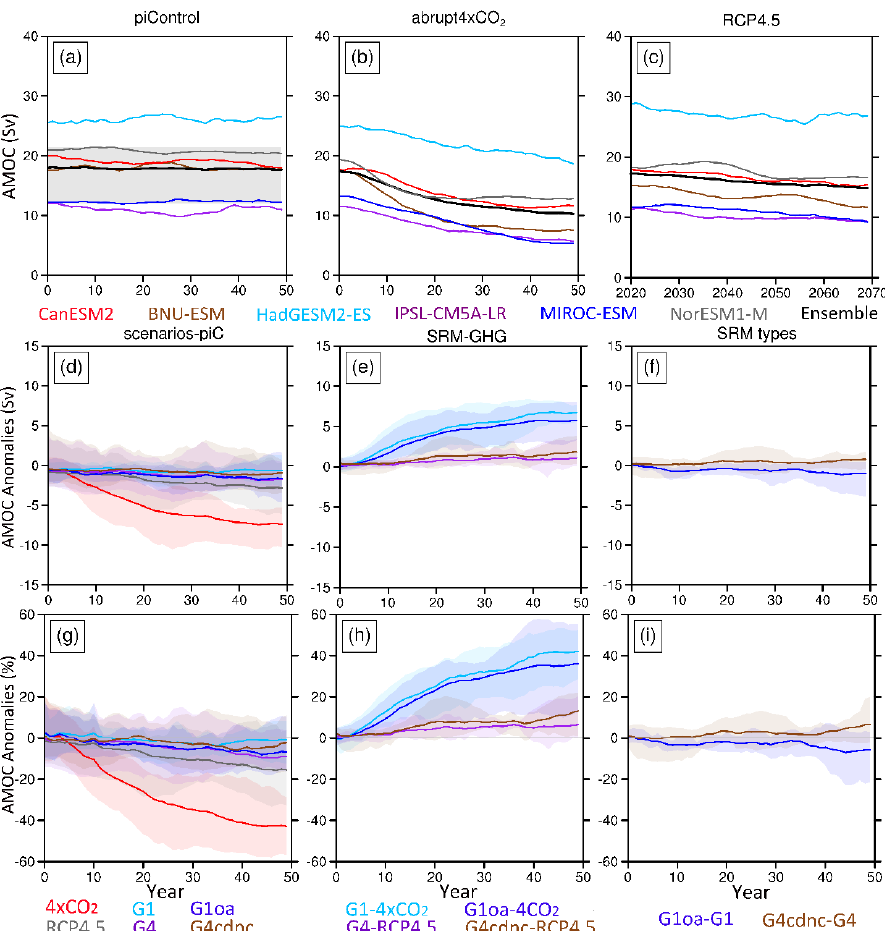
Figure 2. The 11-year running annual means simulated by the six ESMs and the multimodel ensemble mean (black curve) of the AMOC strength (Sv) over the 40-year analysis period under (a) piControl, (b) abrupt4 × CO 2 and (c) RCP4.5. The gray band in (a) is the range of AMOC intensity (17.0 ± 4.4Sv) measured by the RAPID- MOCHA (Frajka-Williams et al., 2019). Panels (d) – (f) show AMOC anomalies (Sv), and panels (g) – (i) show the percentage changes relative to the other scenarios: left column (d, g) relative to piControl; middle (e, h) relative to global warming scenarios (RCP4.5 and abrupt4 × CO 2 ); right (f, i) relative to other geoengineering scenarios (G1oa-G1; G4cdnc- G4). Colored bands in panels (d) – (i) represent the across-ESM spread. G1oa refers to G1oceanAlbedo, and piC refers to